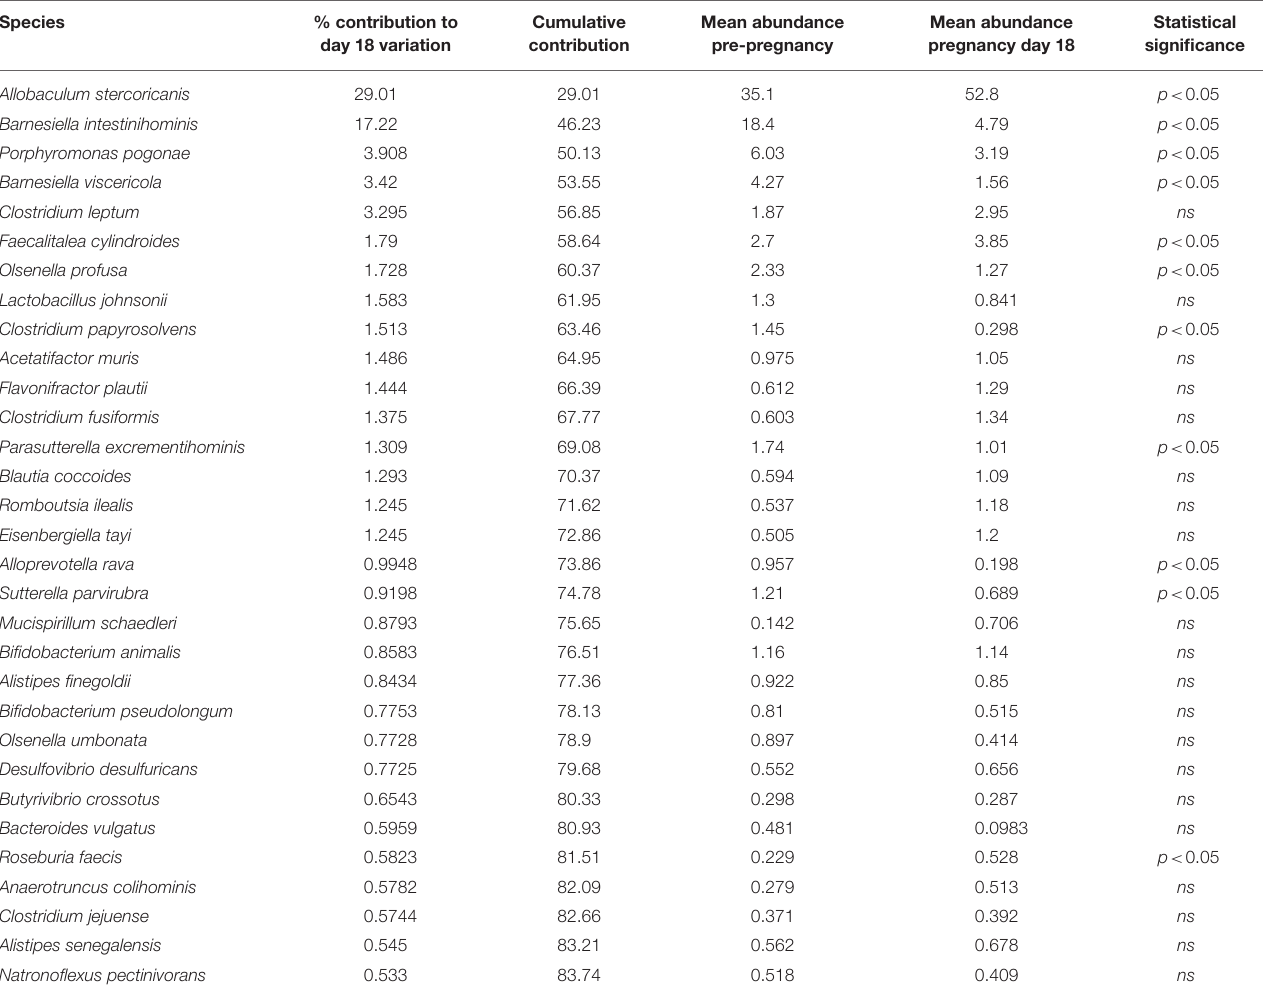
TABLE 3 | The microbiota species explaining the difference in gut microbiome at day 18 of pregnancy vs. pre-pregnancy. Species